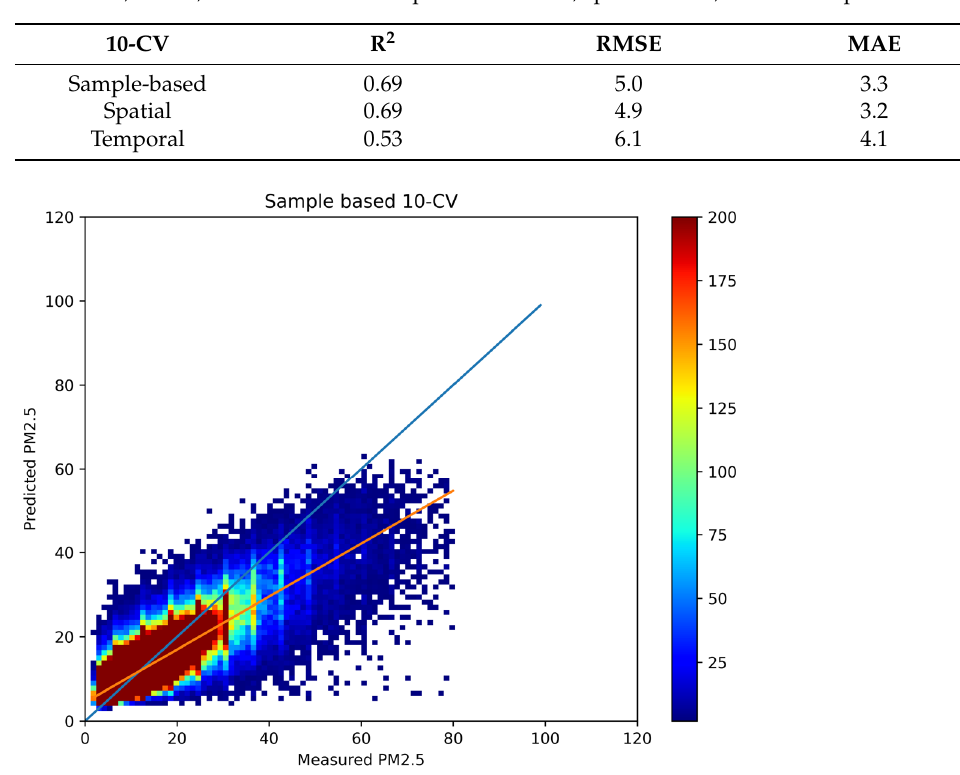
Table 2. R 2 , RMSE, and MAE of the sample-based 10-CV, spatial 10-CV, and the temporal 10-CV.